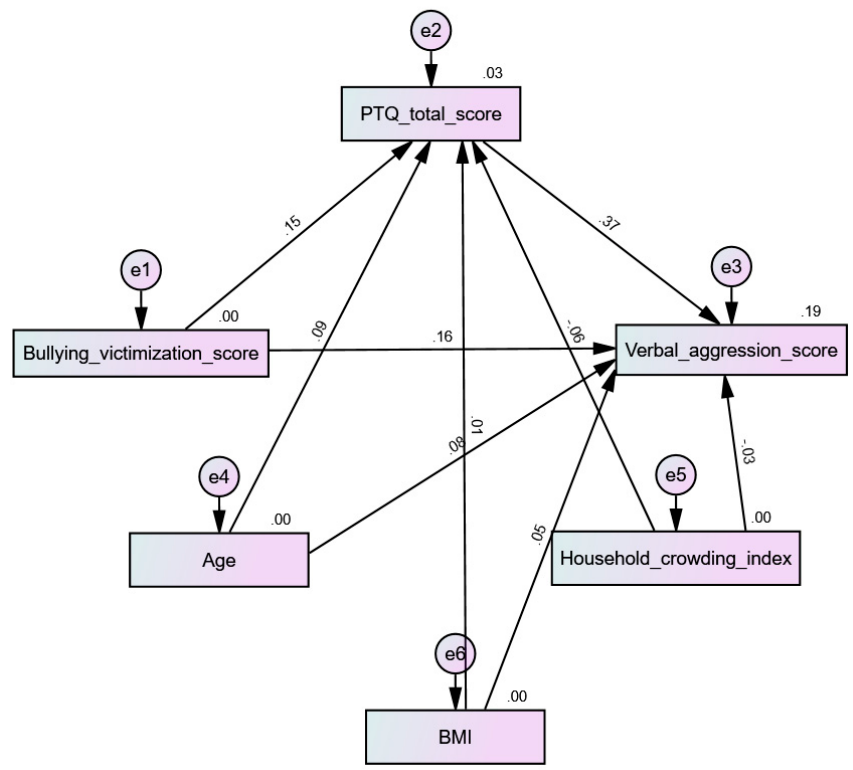
Figure 3. Path analysis model with physical aggression as the dependent variable.